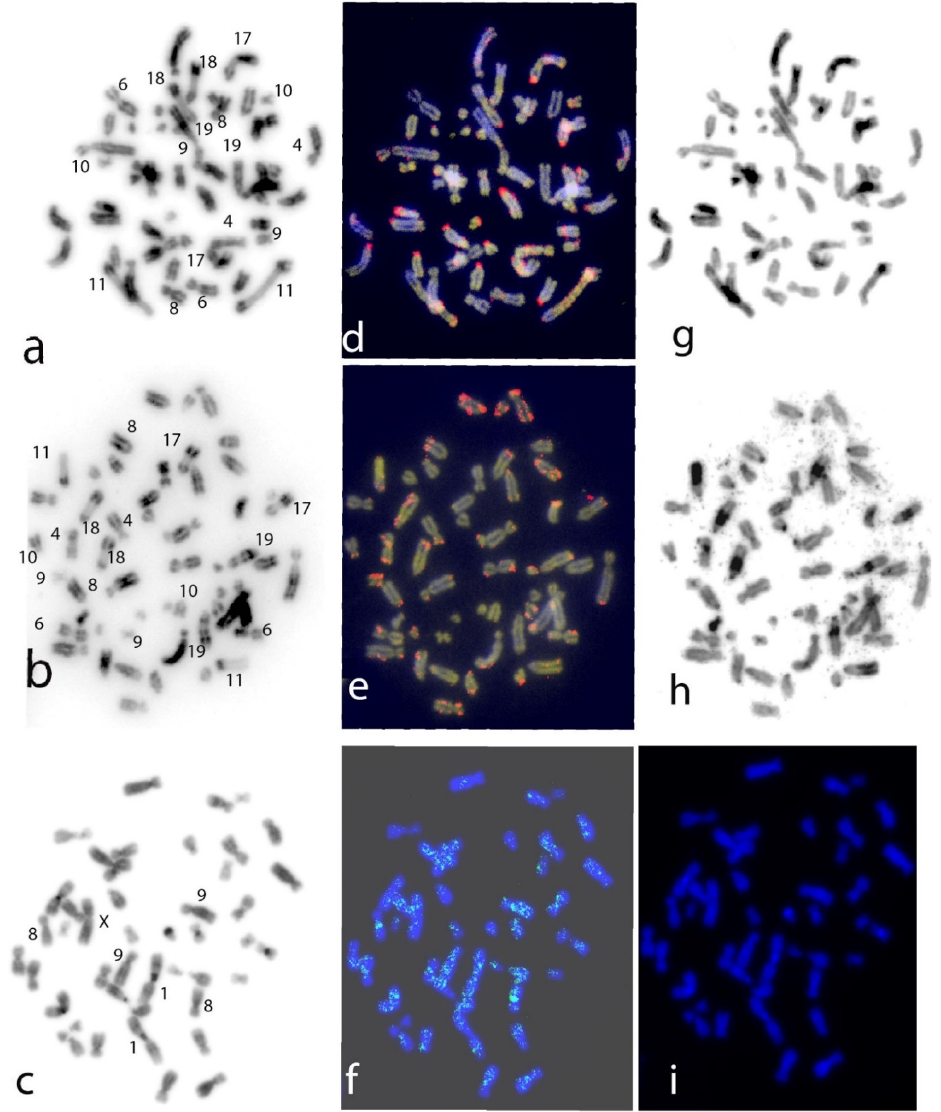
Figure 1. Examples of sequential stains and LINE-1 FISH mapping in the analysed species; from left: DAPI inverted staining before FISH (some representative chromosome pairs have been identified with numbers, see Figure 2 for the complete karyotypes), DAPI/CMA3 (blue/yellow) stains/LINE-1 probe localisation pattern (red) in overlapping, and the C banding after FISH onto the same mitotic metaphase, respectively, in S. apella (SAP), ( a , d , g ) and in C. capucinus (CCP), ( b , e , h ). In H. sapiens (HSA); from left: C banding after FISH ( c ), LINE-1 probe localisation pattern (green) ( f ), DAPI staining after FISH ( i ).